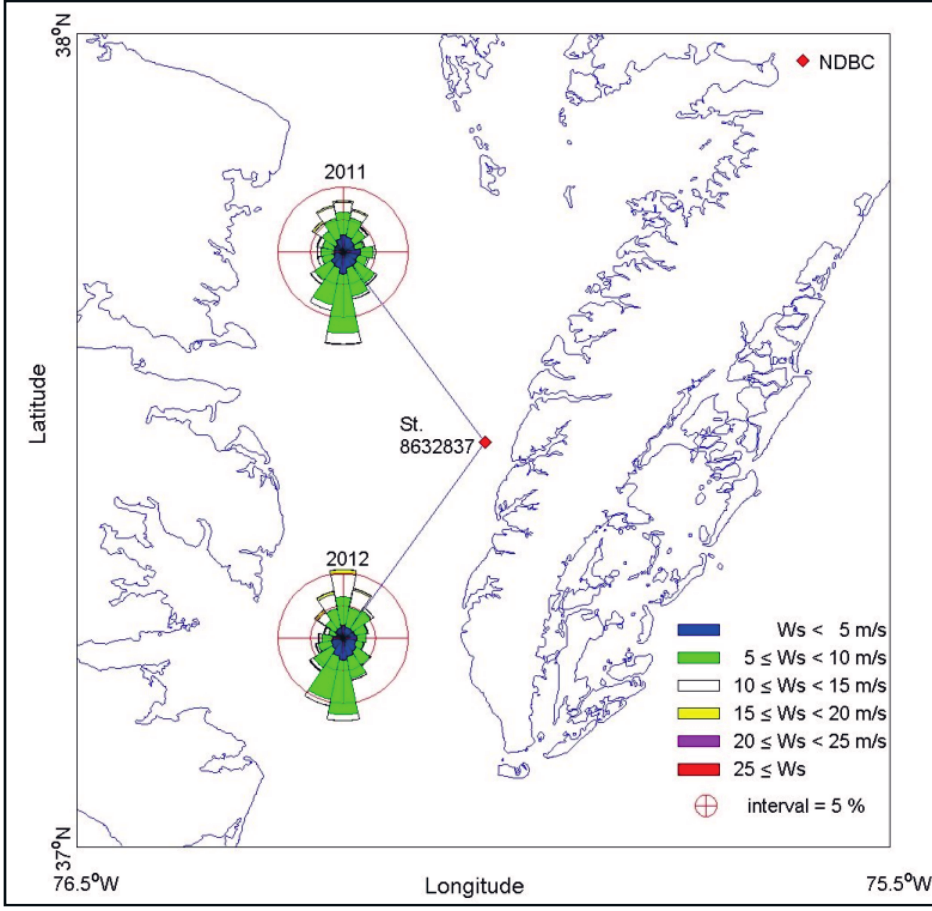
Figure 3. Wind roses for year 2011 and 2012 at NOAA Station